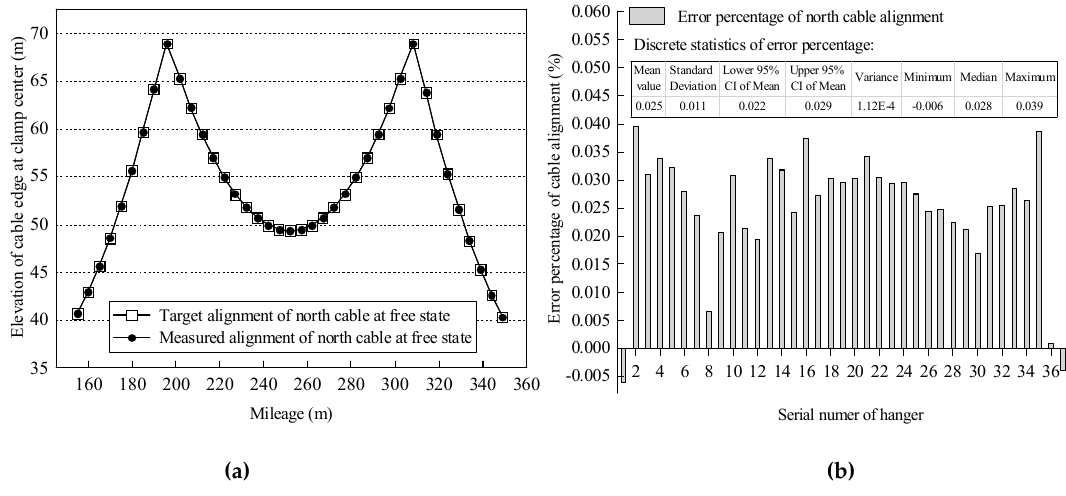
Figure 16. Erection alignment of north cable. ( a ) Cable alignment. ( b ) Error percentage.